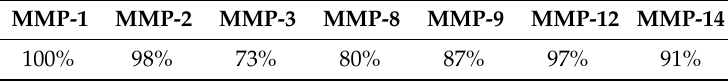
Table 3. Selectivity profile of 14i against a variety of MMPs 1